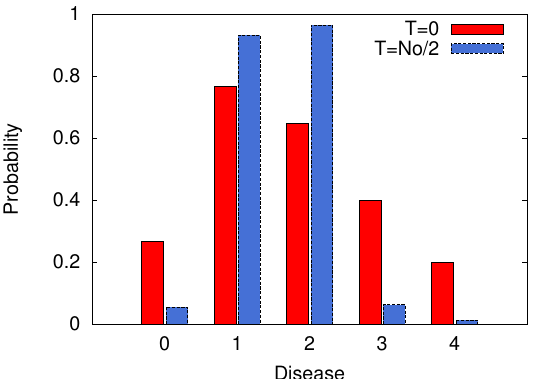
Figure 3. The impact of observing the most polarizing signs on the disease probabilities. The numbers of signs and diseases in this example are N S = 20 and N D = 5, respectively. The probabilistic sign–disease model is constructed by using synthetic conditional probabilities P ( S i concentrated around the sign values randomly assigned to the diseases. The disease probabilities are computed exactly by an exhaustive algorithm (more details can be found in reference [84]). Given the N O = 4 initially observed signs, the algorithm anticipates the values of T other signs that would make the disease probabilities more decisive (closer to zero or one).